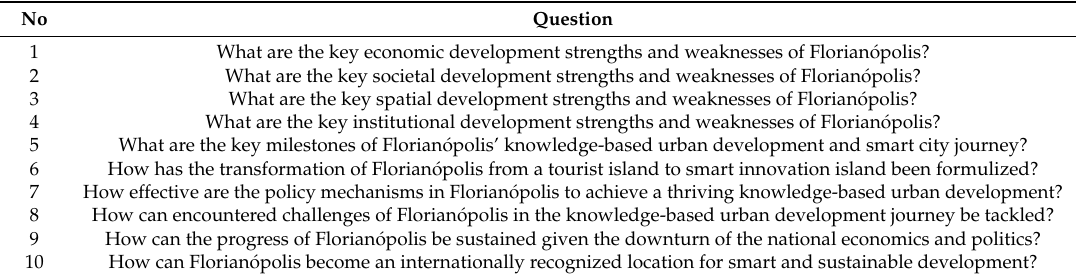
Table 2. Five-what and five-how discussion starter